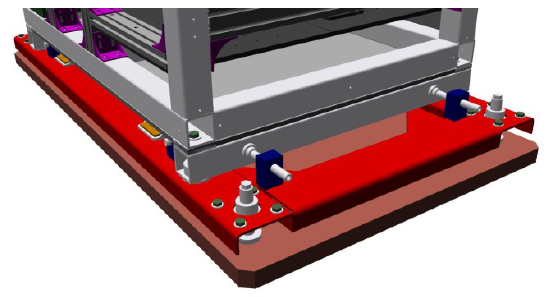
Fig. 7. Optical enclosure supporting frame. Screws and bolt allow tuning the position, orientation, height and tilt of the enclosure with respect to the ECEI beam.